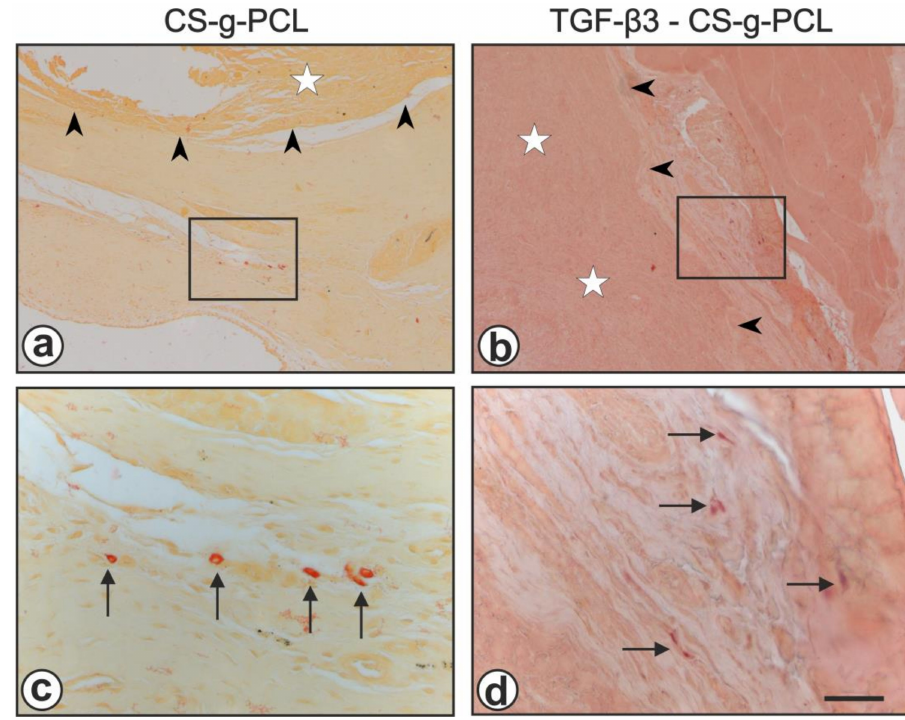
Figure 6. Chloroacetate esterase staining showed the absence of an acute inflammation, both in the CS-g-PCL group ( a , c ) and the TGF– β 3–CS–g–PCL—group ( b , d ). The black rectangles in ( a , b ) are shown in higher magnification in ( c , d ). The boundary of the sca ff olds is indicated by black arrowheads, the sca ff olds are marked by white stars and chloroacetate esterase positive neutrophilic granulocytes are marked by black arrows. Bar = 200 µ m ( a , b ); 50 µ m ( c , d